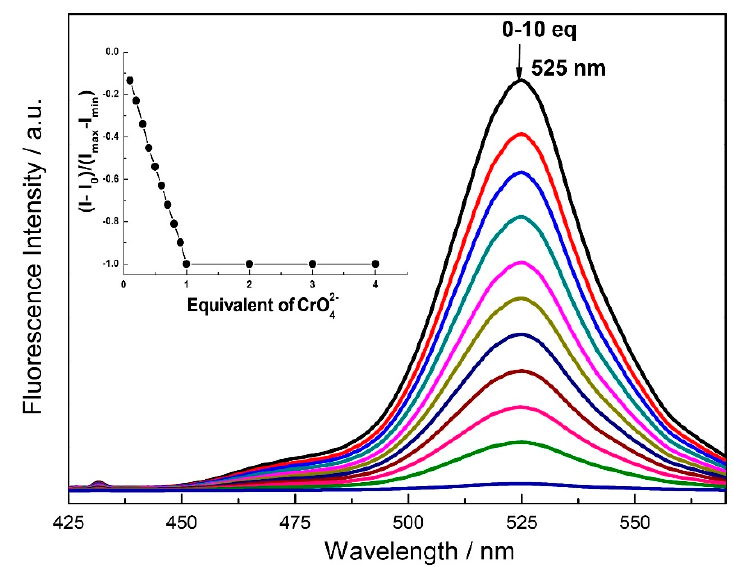
Figure 6. Fluorescence spectra of 2 (1.0 μ M) as a function of added K 2 CrO 4 (10 μ M) in H 2 O:DMF (9:1) containing HEPES buffer (10 mM, pH 7.4). ( λ ex = 330 nm). Inset: mol ratio plot of emission at 525 nm.